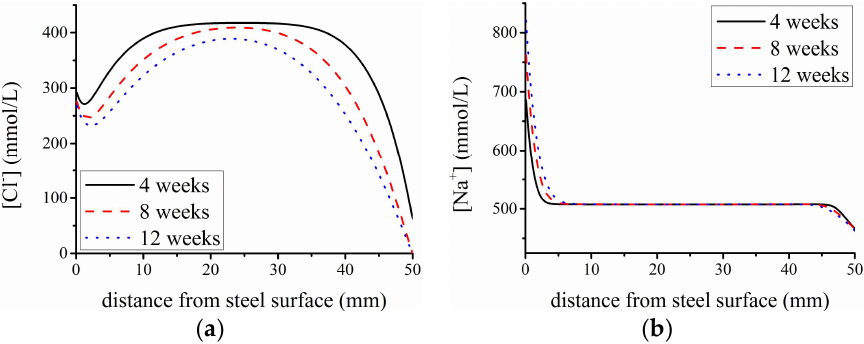
Figure 3. The concentration profiles of cations and anions within the concrete cover after 4, 8, and 12 weeks of the electrochemical treatment ( a ) Cl − ; ( b ) Na + .